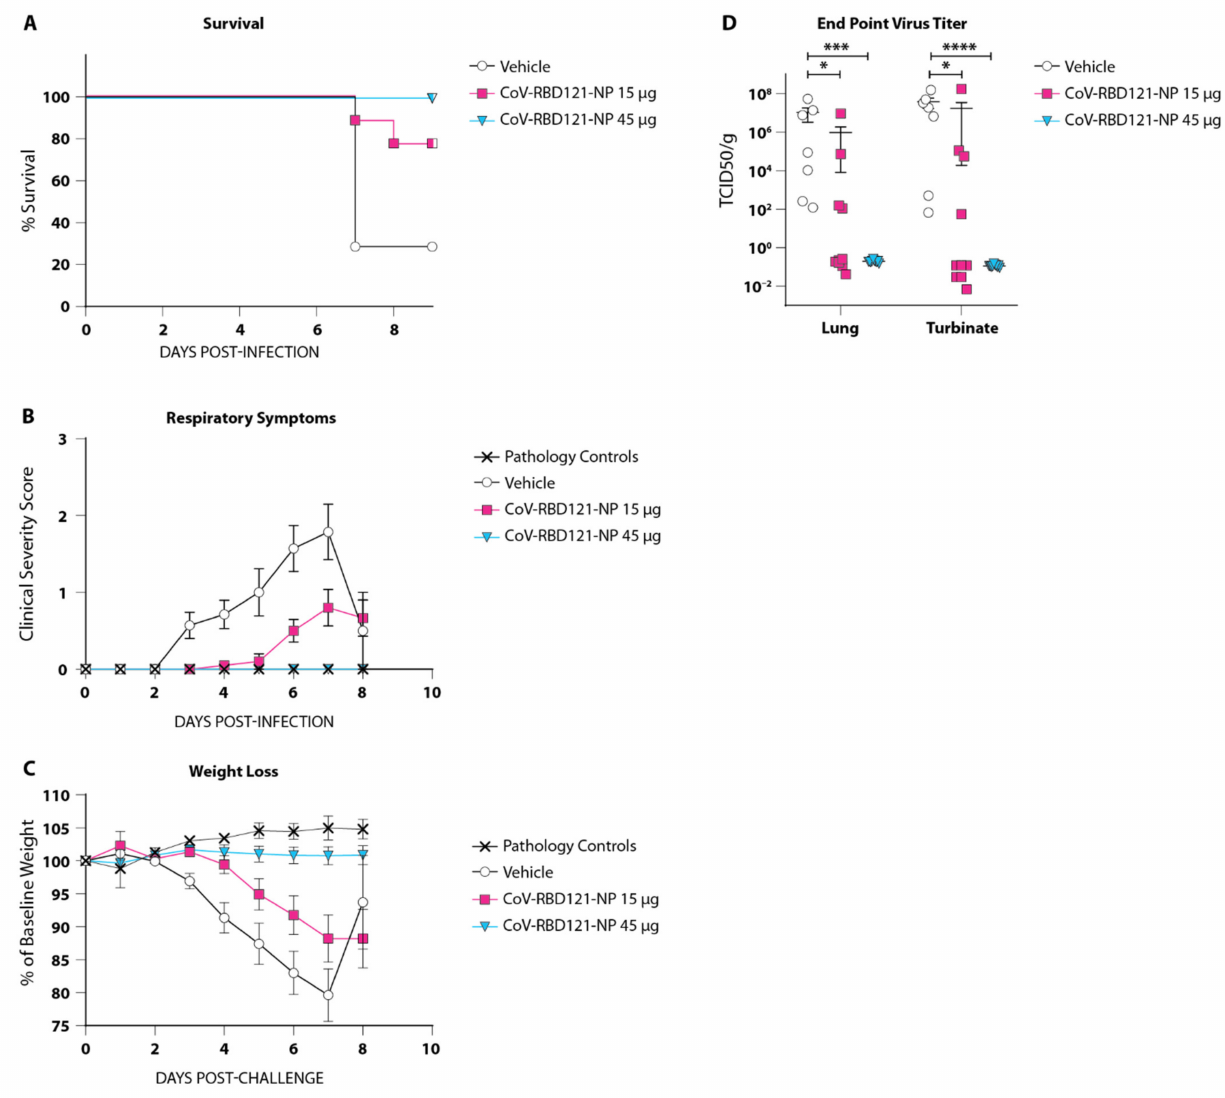
Figure 3. Survival, symptoms, and viral burden in mice vaccinated with CoV-RBD121-NP and challenged with SARS-CoV-2. ( A ) Survival of K18-hACE2 mice following challenge with SARS-CoV-2 (1 × 10 5 pfu administered intranasally). Compared to the mice receiving vehicle, survival was significantly increased for the group receiving 2 doses of 15 µ g of the vaccine ( p = 0.0420) and for the group receiving 2 doses of 45 µ g of the vaccine ( p = 0.002) by log-rank test; vehicle, n = 7; 15 µ g CoV-RBD121-NP group, n = 10; 45 µ g CoV-RBD121-NP group ( n = 10). ( B ) Respiratory symptoms following SARS-CoV-2 challenge were assessed on a scale of 0–3 and plotted as the mean ± SEM for each group. Pathology controls are mice that were not challenged with SARS-CoV-2 ( n = 3). Compared to mice receiving vehicle, symptoms were significantly reduced on day 6 and 7 post-infection for mice receiving 45 µ g CoV-RBD121-NP ( p < 0.0001 for both days) or 15 µ g CoV-RBD121-NP ( p = 0.0062 for day 6 and p = 0.0146 for day 7). ( C ) Weight of mice in the indicated groups was measured and plotted as the mean ± SEM percent reduction from baseline for each group. ( D ) Viral titers were assessed on day 10 after challenge or upon death from lungs and nasal turbinates of mice in each group and are plotted as the median tissue culture infectious dose (TICD50) per gram of tissue. Compared to mice receiving vehicle, viral titers were significantly reduced in the lungs ( p = 0.0005) and nasal turbinates ( p = 0.0008) from mice in the 45 µ g CoV-RBD121-NP group. Statistical differences were calculated with one-way ANOVA with Tukey’s post hoc test in B and C and with two-way ANOVA in D with Kruskal–Wallis test, * p < 0.05; *** p < 0.001; **** p < 0.0001. Key for A and D is presented to the right of D; key for B and C is presented to the right of